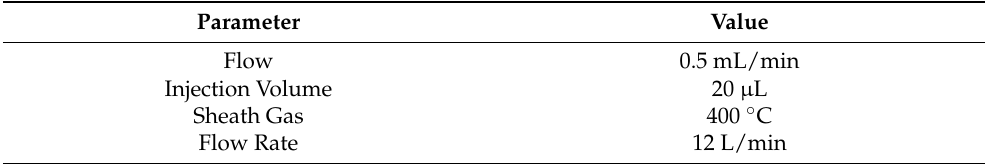
Table 3. Q-TOF LC/MS method